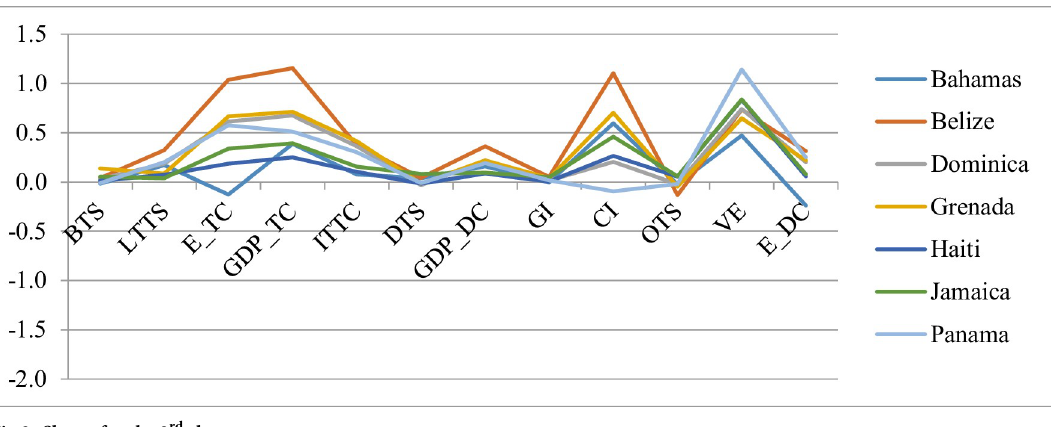
Fig 2. Slopes for the 3 rd